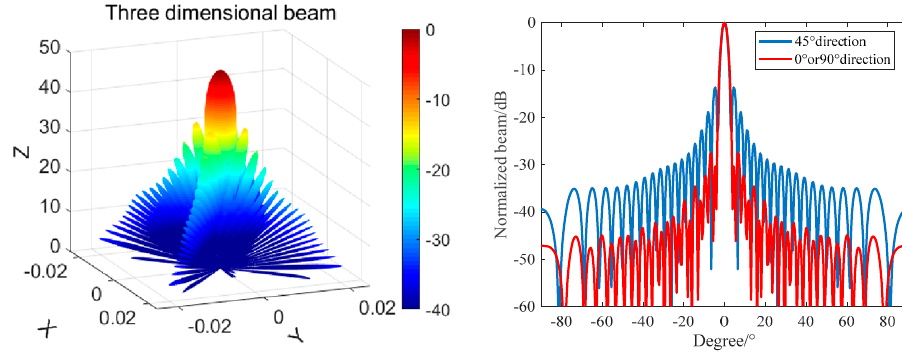
Figure 9. An octagonal rotationally symmetric composite array beam with F = 390 kHz.